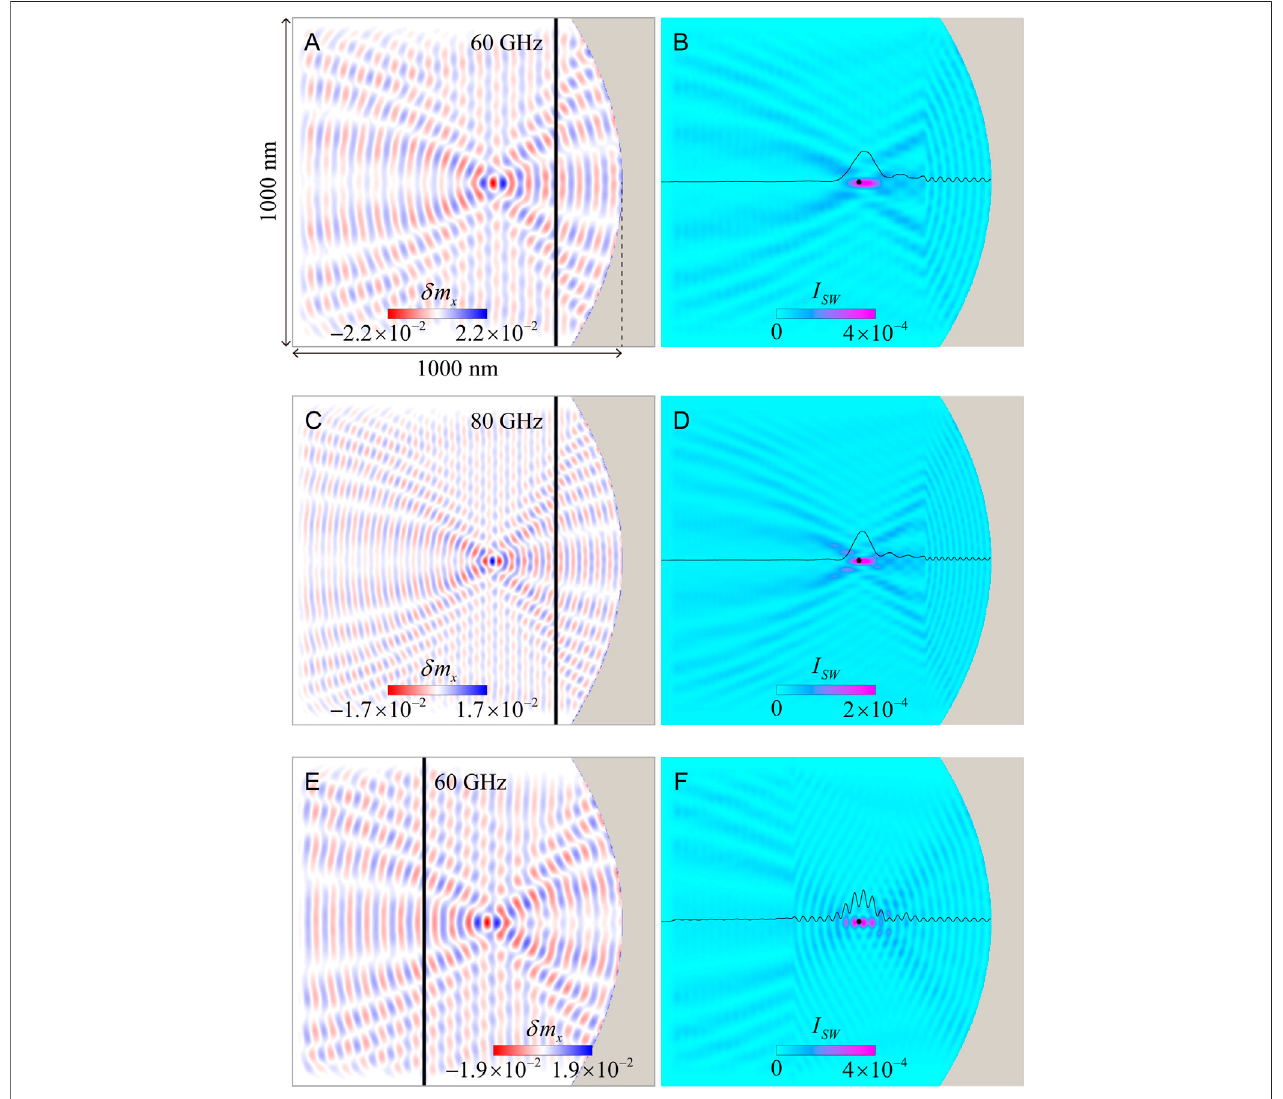
FIGURE 2 | (A) Snapshot of the spin waves re fl ected from the parabolic edge. The spin wave frequency is ω /2 π (cid:2) 60 GHz. The black bar in (A) denotes the spin wave source located at x (cid:2) − 200 nm, which is excited by a microwave fi eld with μ 0 h 0 (cid:2) 10 mT. (B) The spin wave intensity in (A) . The black point represents the ideal position of the focal point. The black curve shows the pro fi le of the spin wave intensity along the x axis at y (cid:2) 0. (C) and (D) Snapshot of total-re fl ection focusing of spin waves and the corresponding intensity for ω /2 π (cid:2) 80 GHz. (E) and (F) Snapshot of spin waves and their intensity for the exciting source located at x (cid:2) − 600 nm.